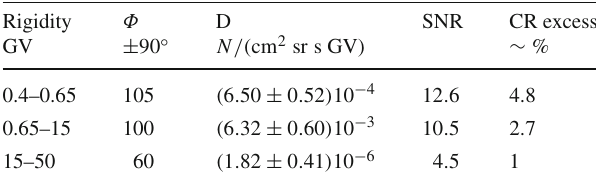
Table 2 Results. The Φ value at the center of the flat tops in Fig. 3, the difference D between the average flux with Φ − 90 ◦ < Φ EJ < Φ + 90 ◦ andtheaveragefluxoutsidethisrange,SNRandthepercentage excess of cosmic ray calculated as D/(average flux). The average flux is obtained by the Fig. 2